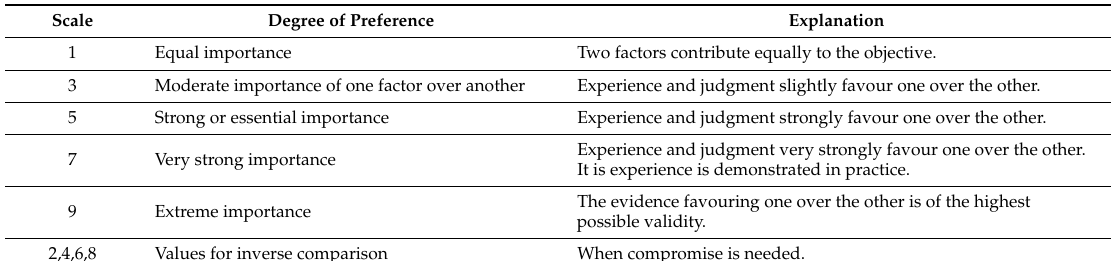
Table 2. Nine degree fundamental scale for a pair-wise comparison matrix by